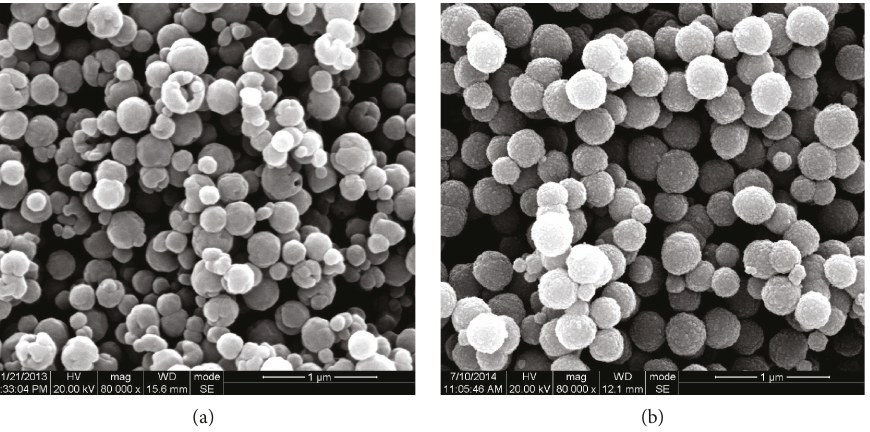
Figure 4: SEM micro images of Fe